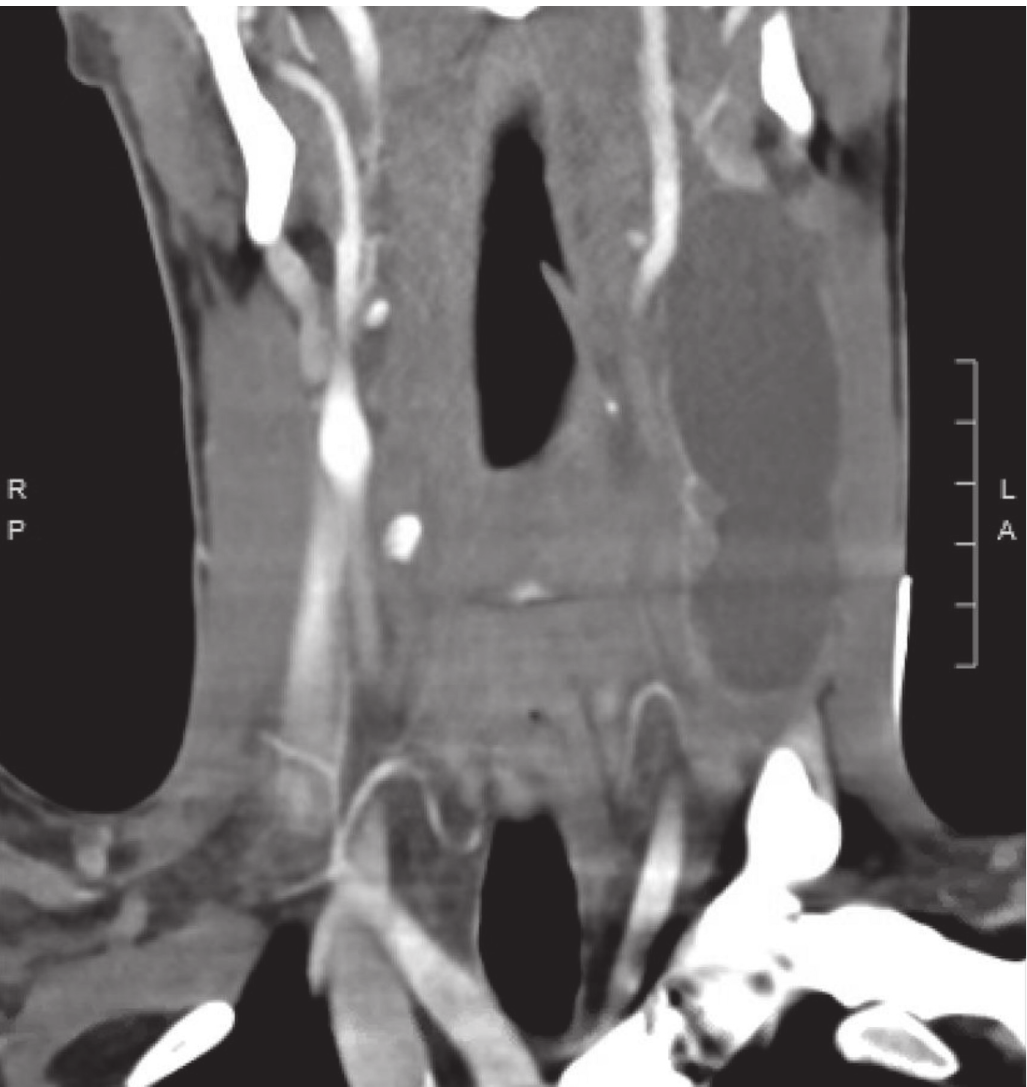
Figure 1: Computed tomography scan of the neck with contrast revealed a 4cm × 8 cm × 3cm cystic mass in the left neck occupying nodal levels 2–4 deep to the sternocleidomastoid